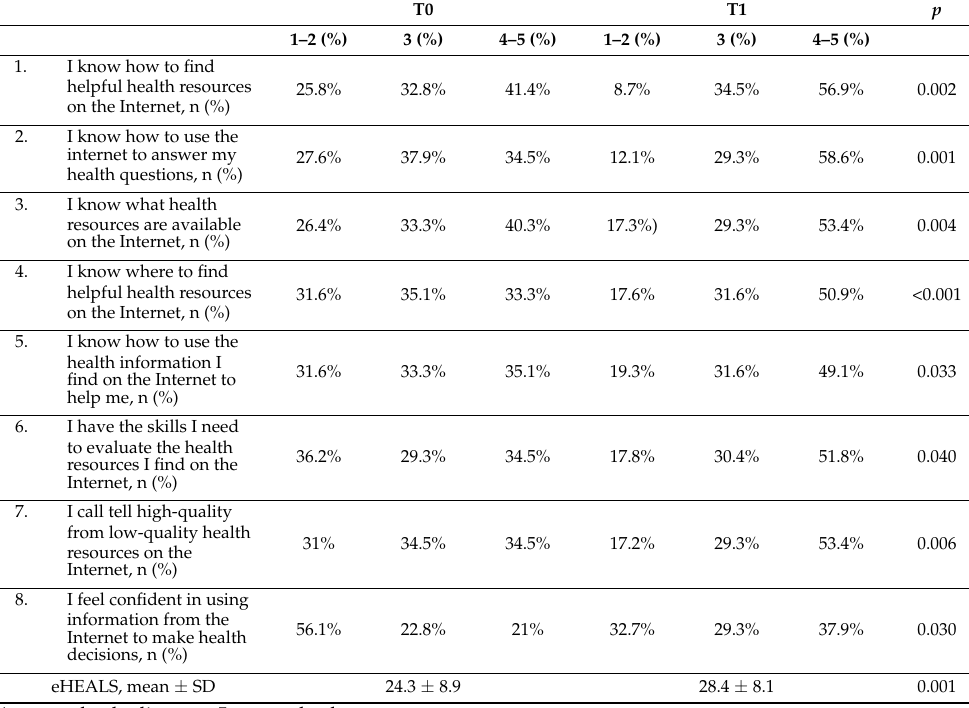
Table 3. eHEALS value at the baseline (T0) and at the end of the course